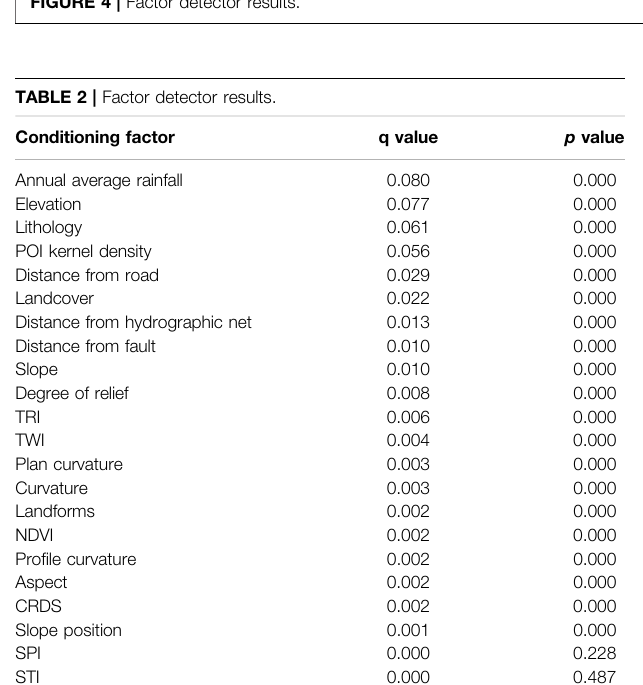
FIGURE 4 | Factor detector results.